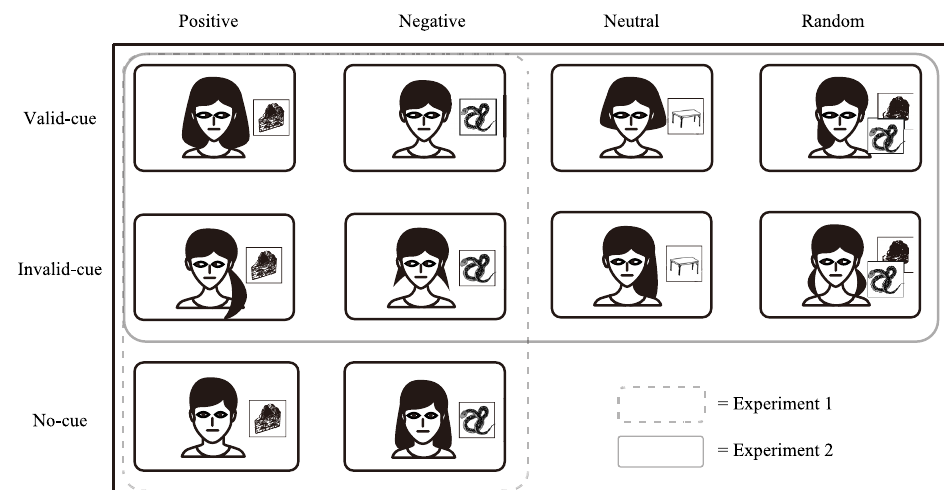
Fig 1. Cells of Experiments 1 and 2. The face-target pairs used in Experiment 1 are surrounded by the dotted line, and those in Experiment 2 are surrounded by the solid line. The vertical part indicates the type of face, and the horizontal part indicates the type of target. In Experiment 1, there were 6 faces (valid-cue, invalid-cue, no-cue) and targets (positive, negative). In Experiment 2, there were 8 faces (valid-cue, invalid-cue) and targets (positive, negative, neutral, random). The faces and the targets in Fig 1 are not the original images that were used in our study, but schematic images used for illustrative